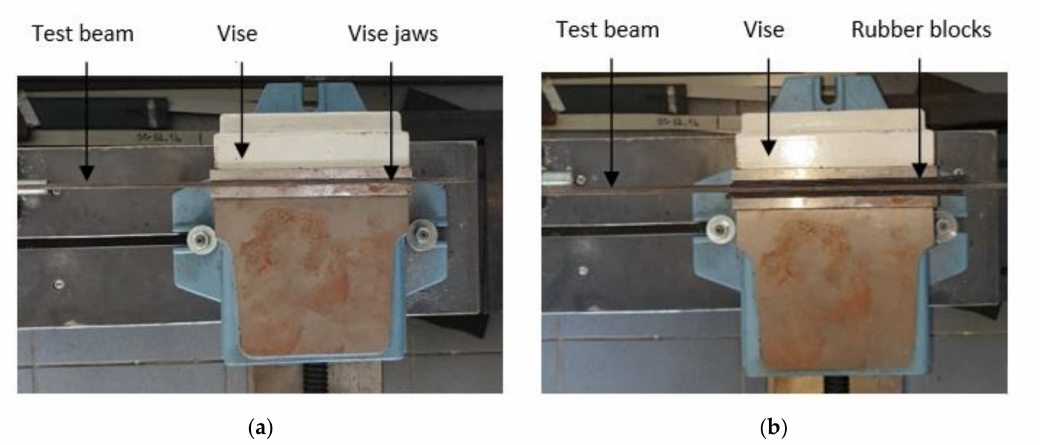
Figure 11. Clamping system: ( a ) rigid clamping obtained by direct fixing in the vise; ( b ) weak clamping obtained by intercalating rubber